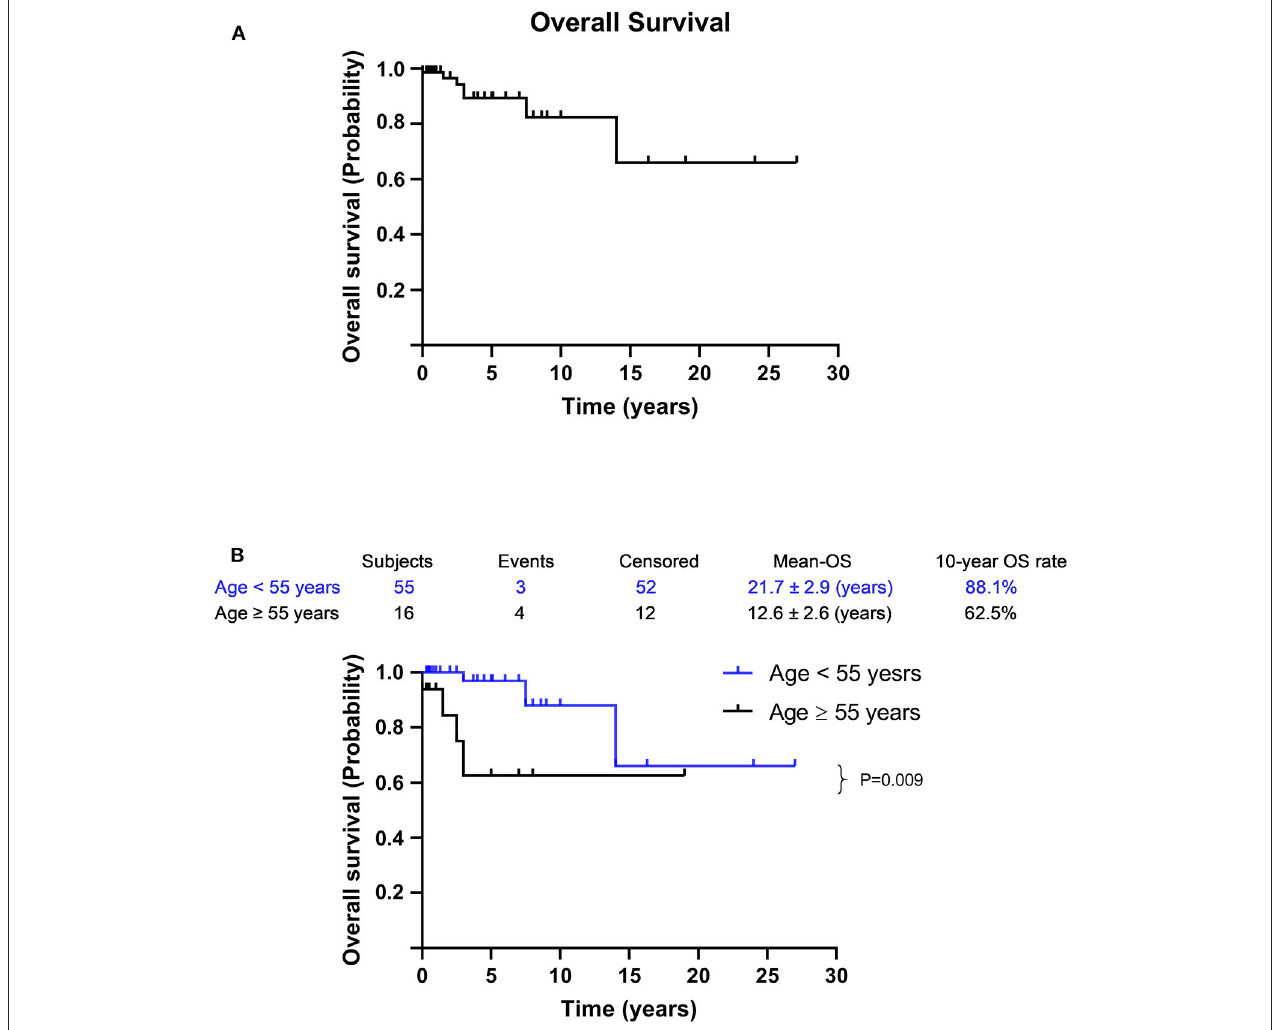
FIGURE 3 | Survival curves for metastatic MSO. (A) The OS for all patients with metastatic MSO. (B) Age < 55 vs. age ≥ 55 years. It was analyzed by Kaplan–Meier (log-rank) test. Percentages of survival patients are shown at indicated time points. Censored patients are marked with “ | ” in the